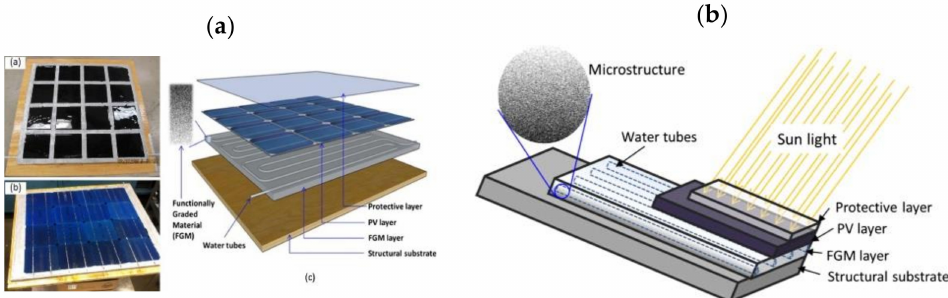
Figure 27. ( a ) Hybrid PVT FGM schematic—first design; ( b ) layers of BIPVT—second design (reprinted from [126], with permission from